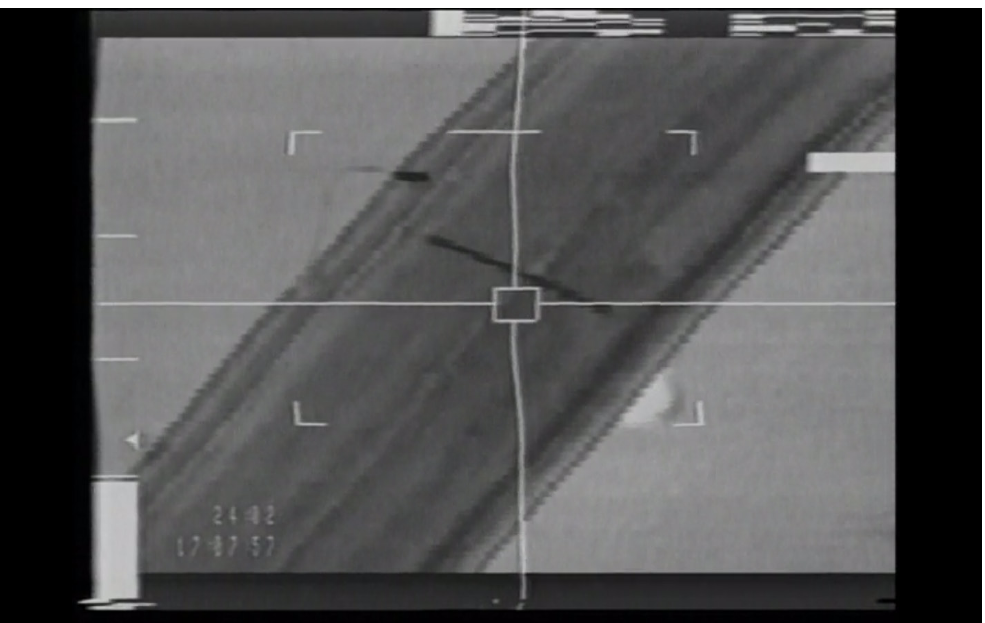
Fig. 8 Farocki H., War at a Distance , 2003. Screenshot from the